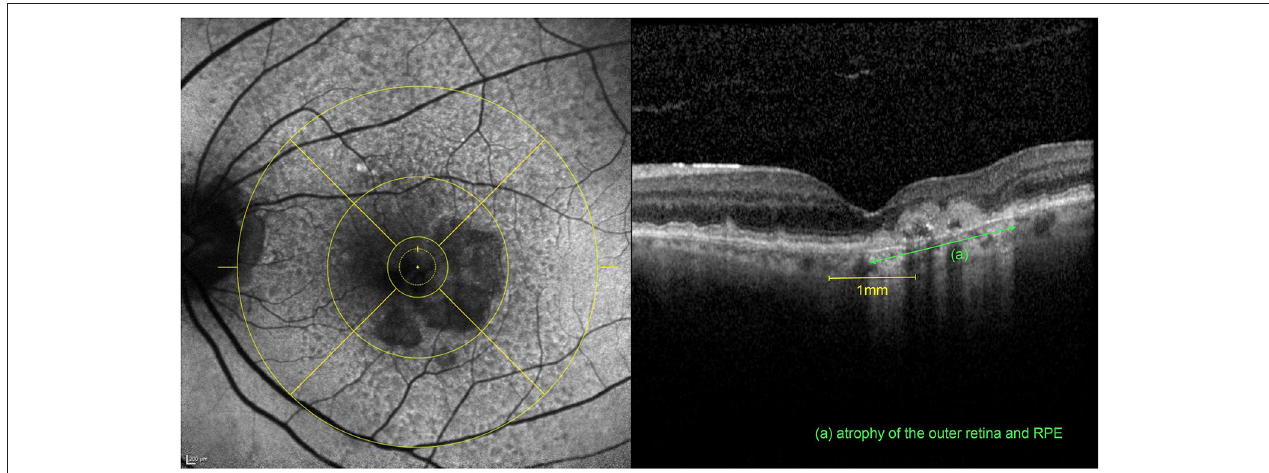
FIGURE 1 | Multimodal imaging of the left eye of an 81-year-old patient after 6 intravitreal aflibercept and 19 ranibizumab injections for nAMD. The patient had a preserved BCVA of 80 letters ETDRS with an already diminished CS (1.20 log units) and monocular MRS (81.28 wpm) (compared to the mean values of all included eyes of 66.7 letters ETDRS, 1.21 log units CS and 96.9 wpm monocular MRS, respectively). Left: FAF image with an ETDRS grid overlay centered on the fovea with a horseshoe-shaped area of atrophy involving the central 1mm. Right: Corresponding volume OCT scan revealing at the same time, an area of intact anatomic preservation on the left, associated with an atrophy of the outer retina (ELM and IS/OS interface disruption) and the retinal pigment epithelium (RPE) (green) on the right within the